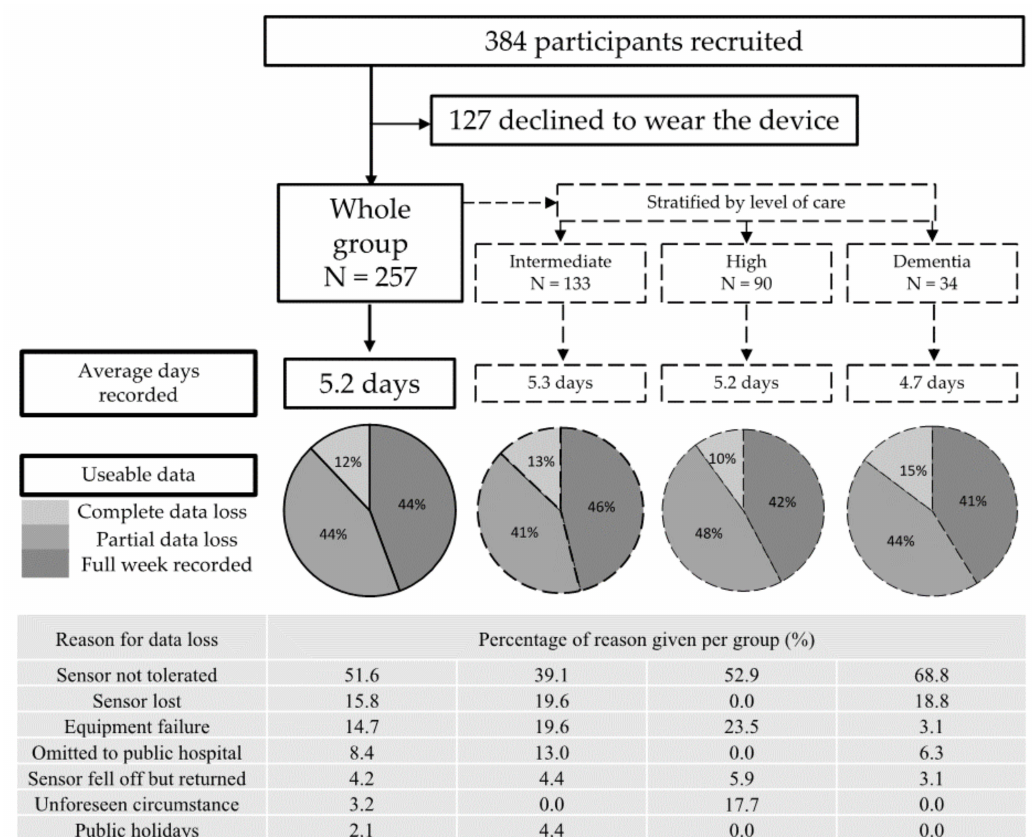
Figure 3. A flow diagram to describe the average number of days recorded, the percentage of full weeks recorded, partial data, or complete data loss. For the participants where a reason for data loss was provided, the reason for the data loss is displayed as a percentage for all explained data loss. The information is provided for all participants and also stratified by level of